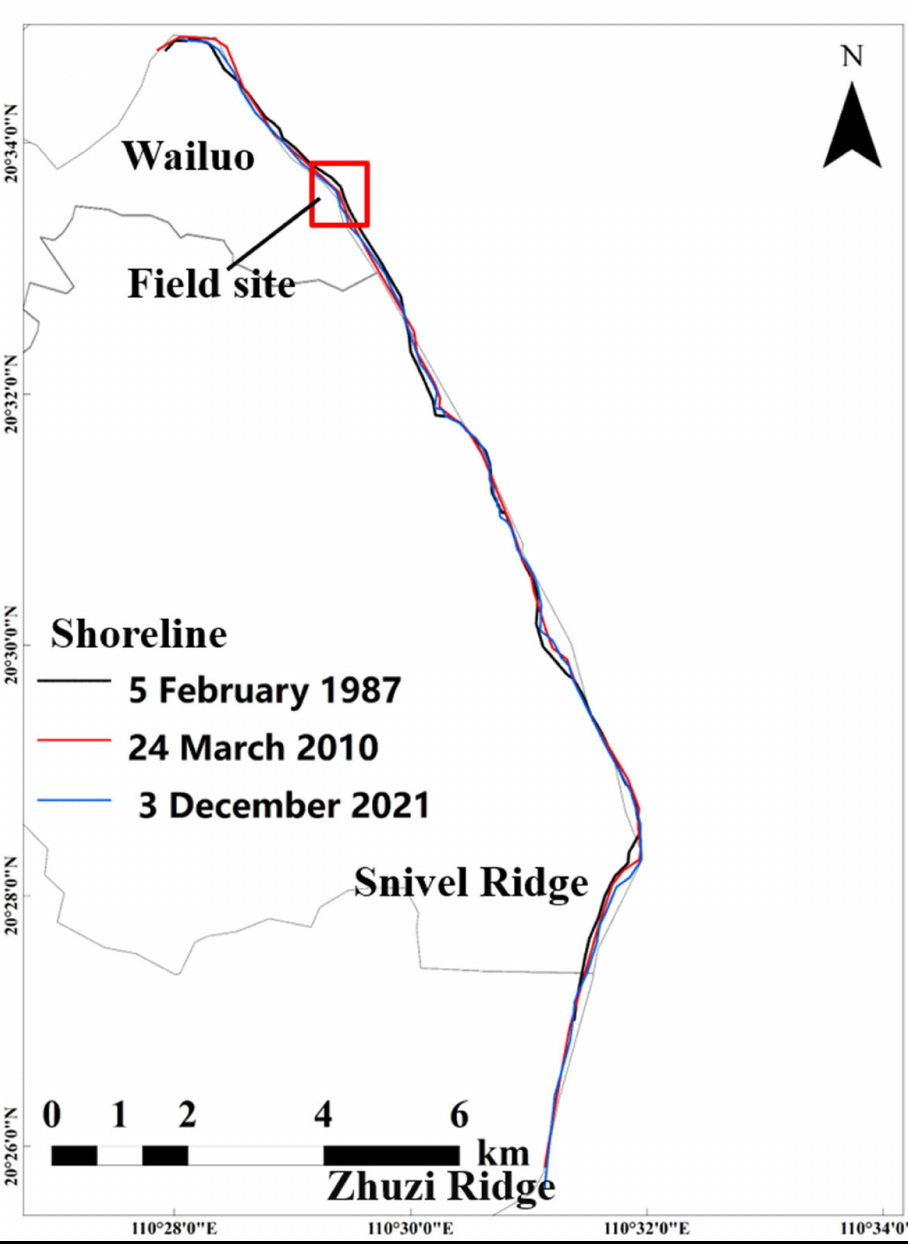
Figure 5. Coastline diagrams of the study area over the years (here, we show the coastlines from three typical periods—1987, 2000, and 2021, which correspond to the earliest, medium, and latest periods,